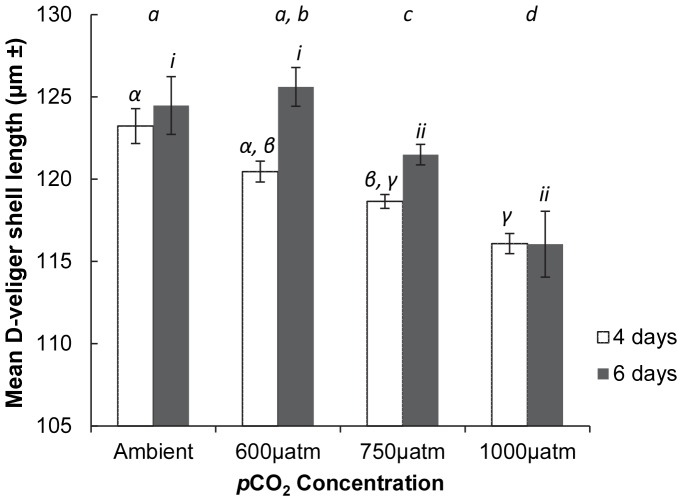
The effects of elevated pCO2 on M. asperrima D-veliger shell length.Mean shell length of M. asperrima D-veliger larvae following 4 and 6 days treatment at ambient and elevated pCO2 levels (390 µatm, 600 µatm, 750 µatm, 1000 µatm) ±MSE, n = 4. Letters above columns represent results of SNK tests, different letters represent significant differences detected, corresponding letters represent no significant differences detected among those treatments. Roman numerals i – ii represent differences among CO2 treatments after 4 days, Greek letters α – β represent differences among CO2 treatments after 6 days and Latin letters a –c represent SNK results of overall mean larval shell length disregarding sampling times.